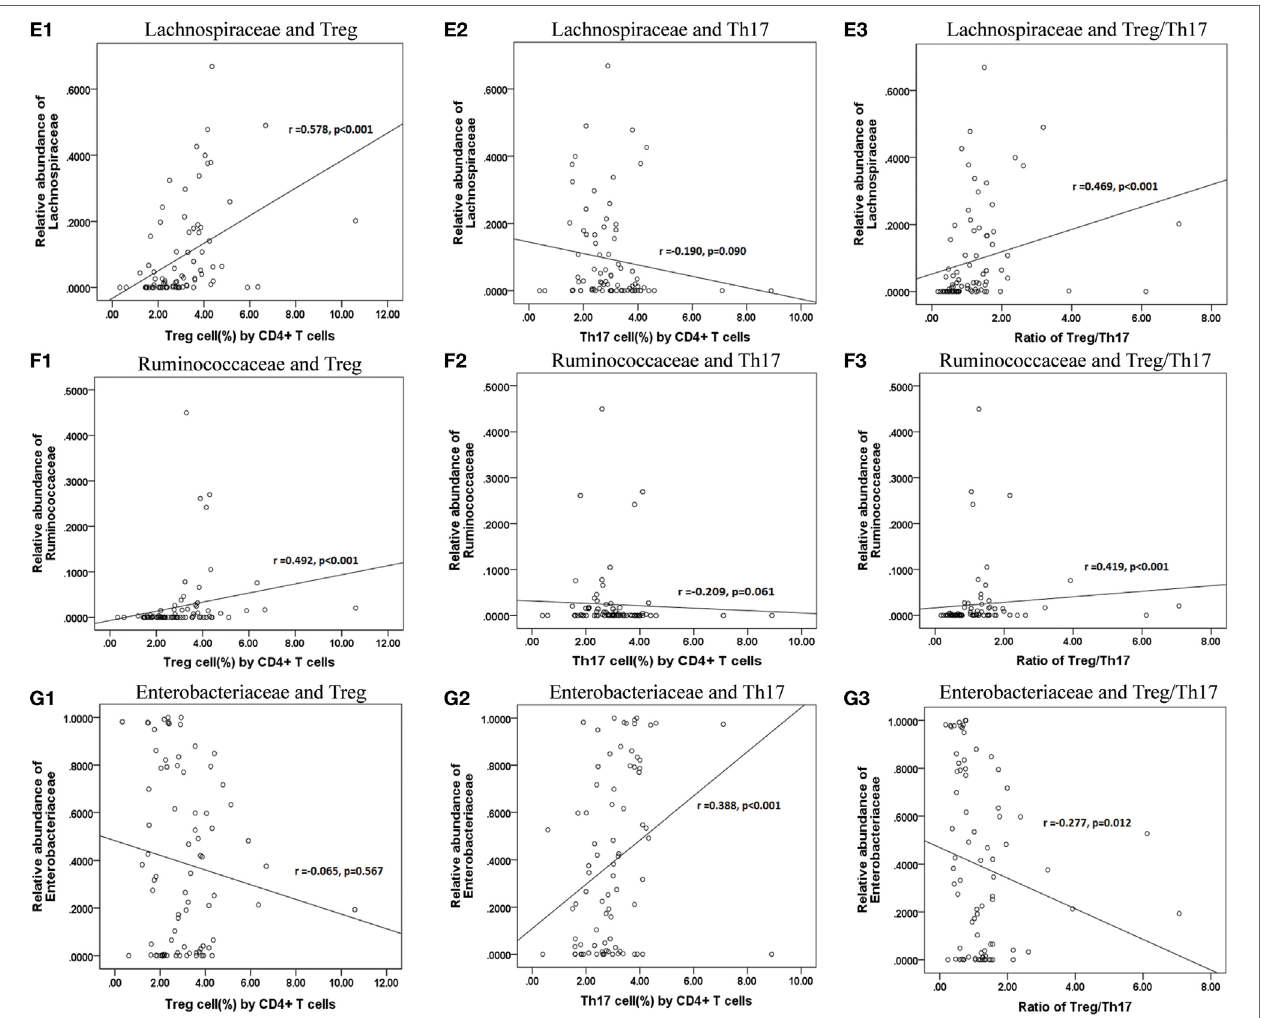
FigUre 6 | The percentage of Treg and Th17 cell counts are associated with aGVHD and intestinal microbiota correlates with the Treg/Th17 balance. The phenotype of regular T cells (Treg) (a) and IL-17-producing T cells Th17 (B) in peripheral mononuclear blood cells was examined. The percentage of Treg (c) and Th17 (D) cells is shown for the two groups. Correlations between the relative abundance of microbiota and percentage of T subsets and the Treg/Th17 ratio ( e1 : Lachnospiraceae and Treg; e2 : Lachnospiraceae and Th17; e3 : Lachnospiraceae and Treg/Th17. F1 : Ruminococcaceae and Treg; F2 : Ruminococcaceae and Th17; F3 : Ruminococcaceae and Treg/Th17; g1 : Enterobacteriaceae and Treg; g2 : Enterobacteriaceae and Th17; g3 : Enterobacteriaceae and